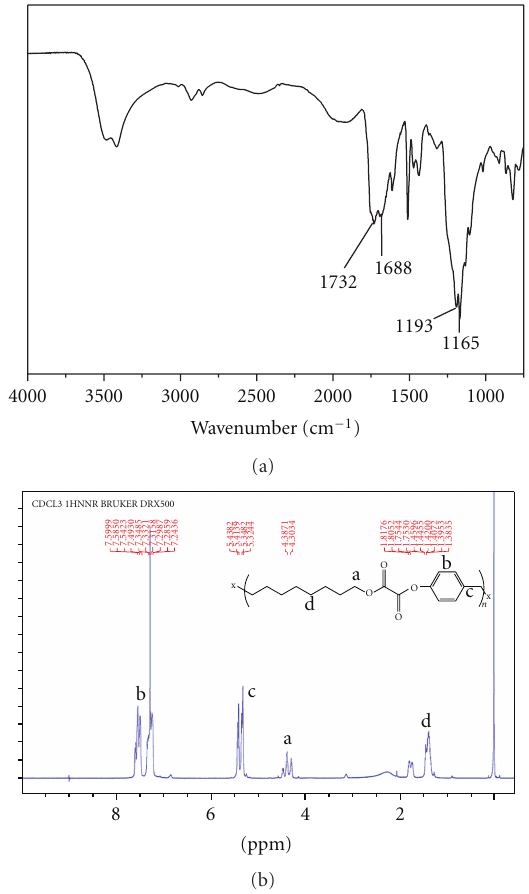
Figure 1: (a) FT-IR and (b) 1 H-NMR spectra of peroxalate ester